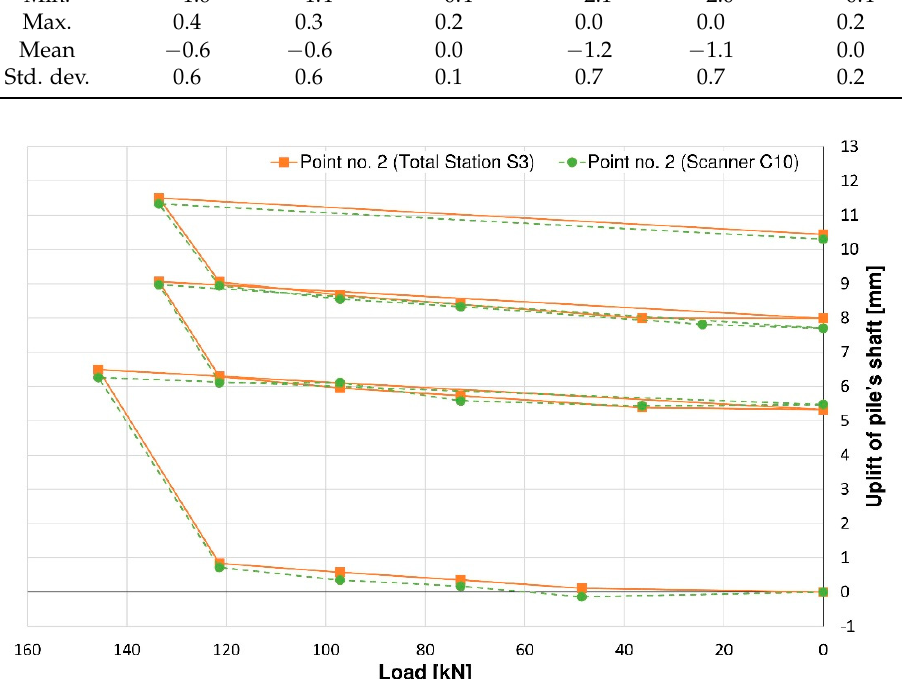
Figure 11. The uplift of the pile’s shaft represented by point no. 2.